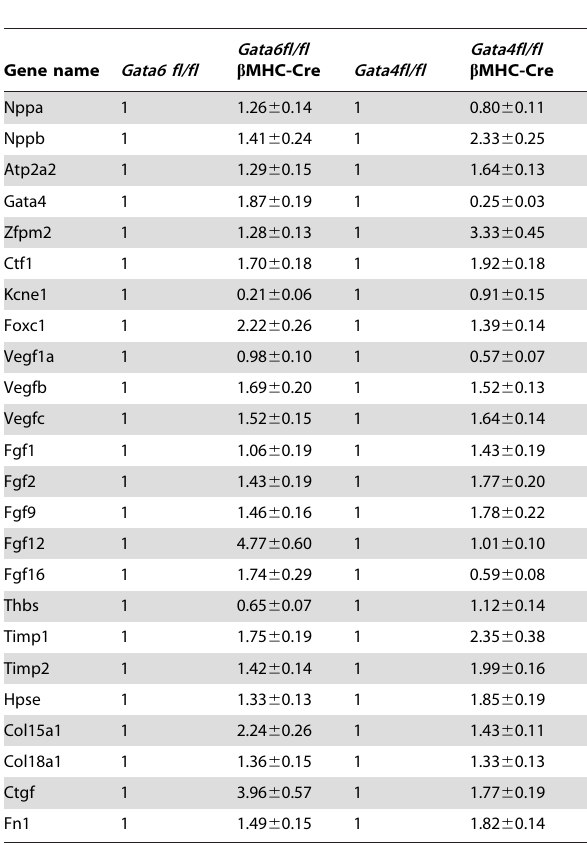
Table 2. qRT-PCR confirmation of differentially regulated genes.